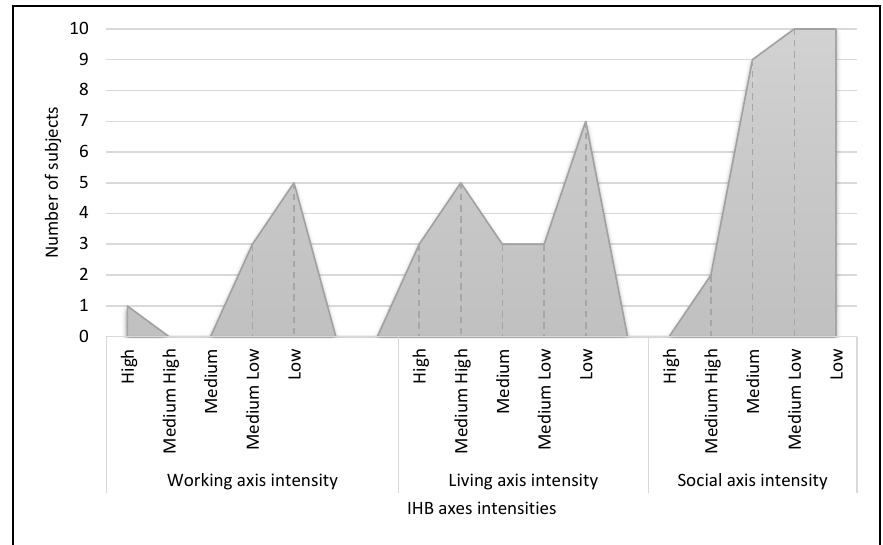
Figure 1. Distribution of the number of subjects in the Individual Health Budget (IHB) group according to working, living, and social axes intensity.